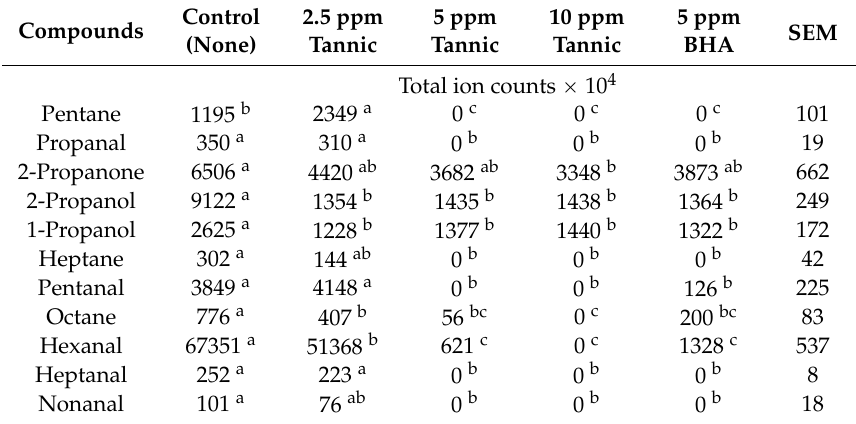
Table 6. Volatile profiles of cooked chicken breast meat with different levels of tannic acid at day